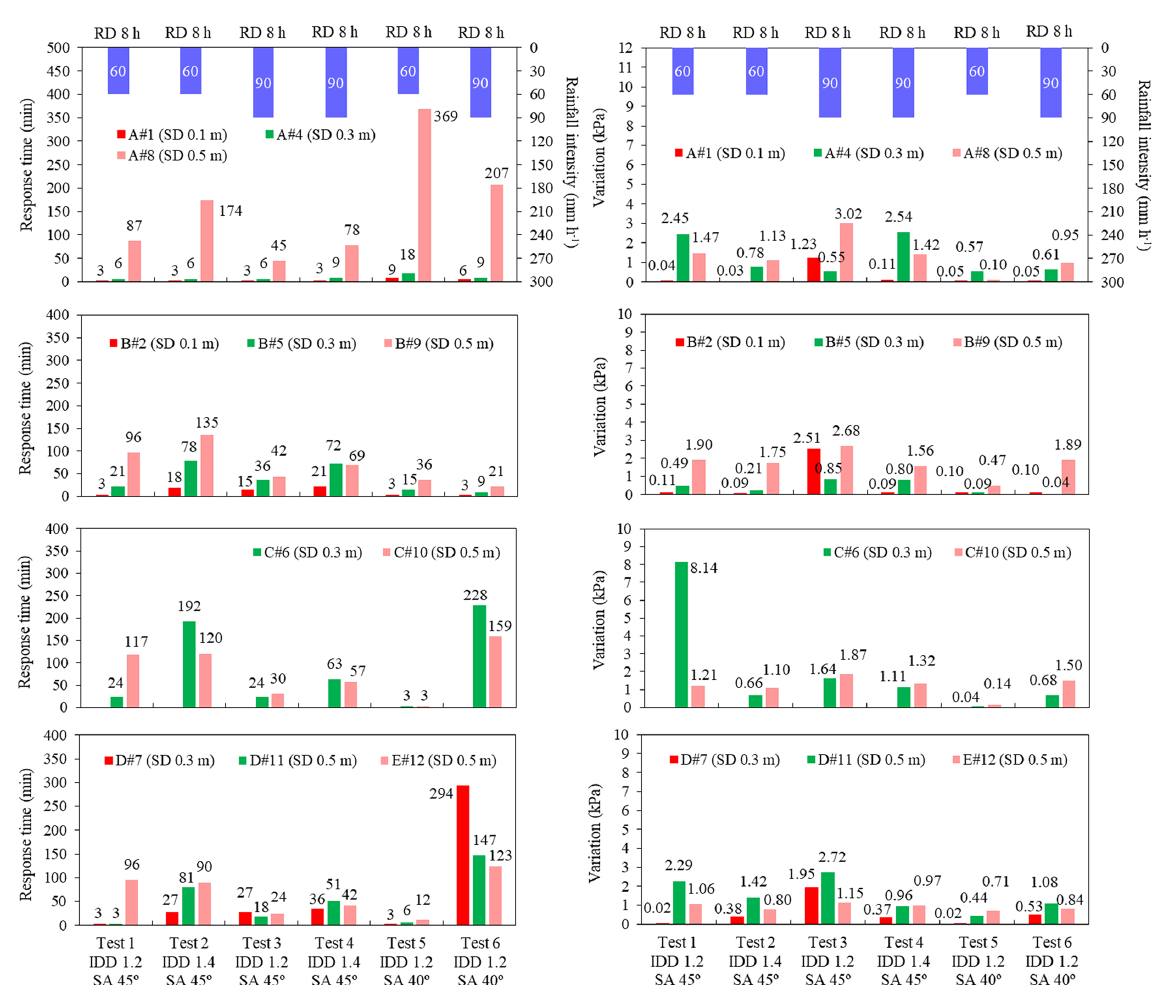
Figure 19. Response time and variation of pore water pressure in six tests during the first rainfall. In this bar chart, IDD represents initial dry density, SA represents slope angle, SD represents sensor depth and RD represents rainfall